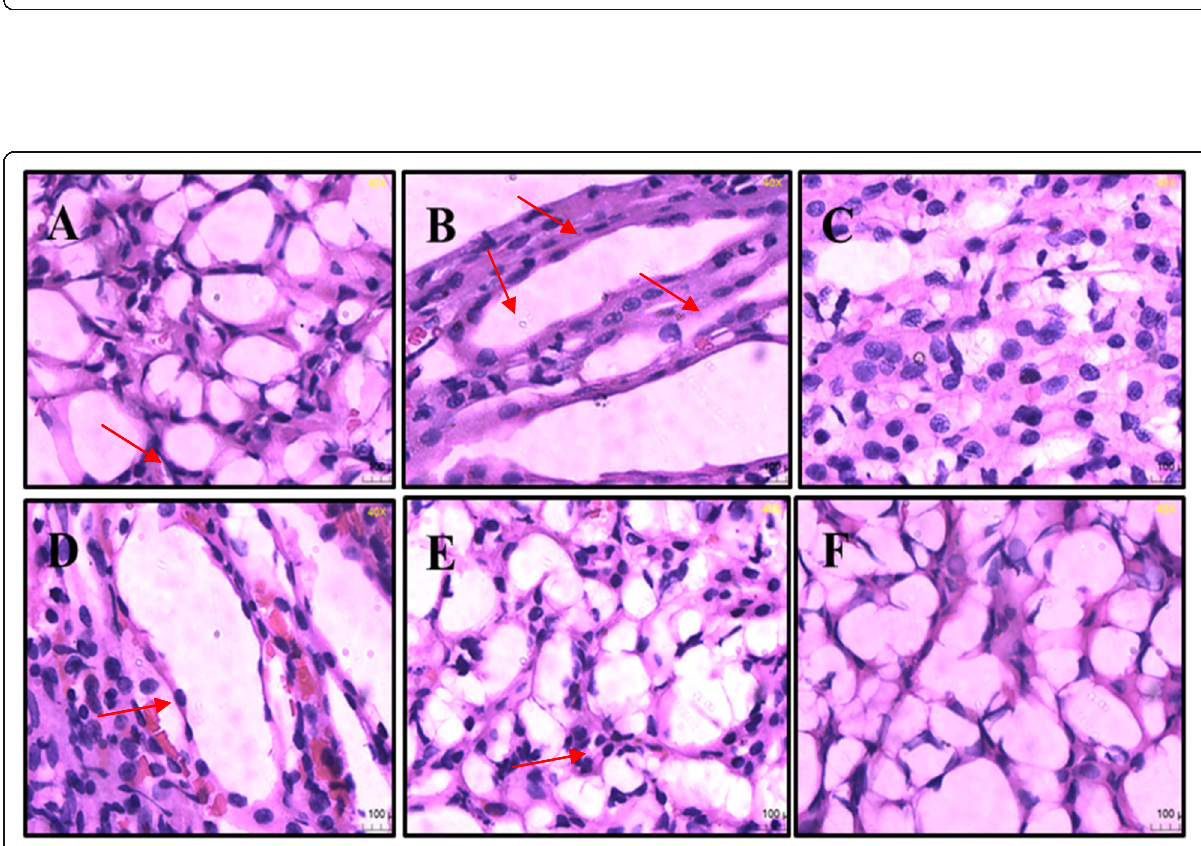
Fig. 5 Effect of STZ and formononetin on cytokine release. Data were presented as mean ± S.E.M. (n-6). The result values were statistically analyzed by using one-way ANOVA followed by Bonferroni ’ s test for multiple